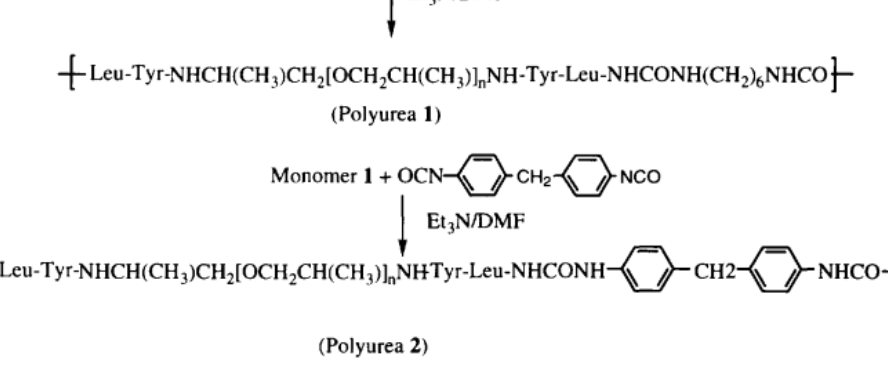
Figure 30. Synthesis of polyureas. From reference [58].